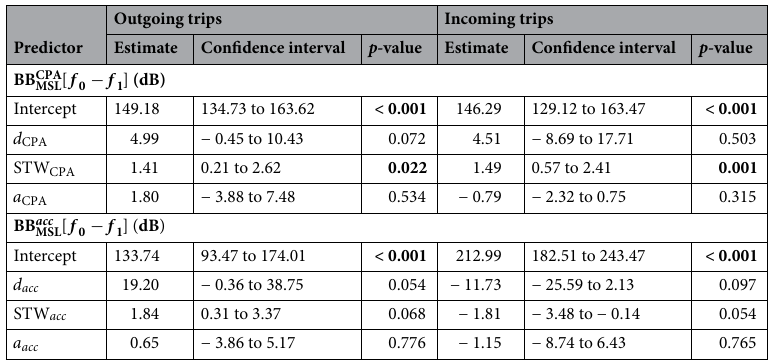
Table 3. Generalized linear mixed models. The null hypothesis can be rejected for p -values shown in bold.